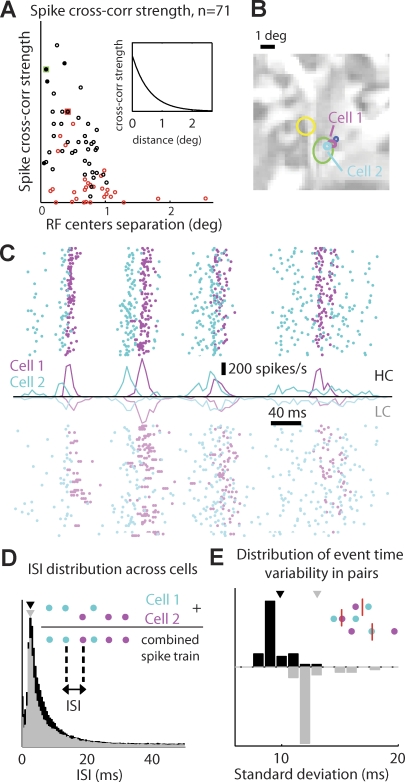
Spike Timing Precision across Cells(A) Correlation strength as a function of the spatial separation between the receptive fields of cell pairs. Each symbol represents a pair of cells (n = 71). Black symbols denote pairs included in the pairwise analysis (n = 41), whereas red symbols denote pairs excluded from further analysis (see Materials and Methods for inclusion criteria). Inset: Spatial correlation profile of the natural scene stimuli.(B) Receptive fields of five cells recorded simultaneously in a single penetration, superimposed (to scale) on a single frame of the visual stimulus.(C) Response of two of these cells during a 500-ms segment of the movie.(D) Distribution of pairwise ISIs (as defined for the combined spike train in inset) over all included pairs (n = 41; see above), at HC (black) and LC (gray).(E) Distribution of pairwise event timing variability (after matching events that overlapped in both cells) for all included cell pairs.